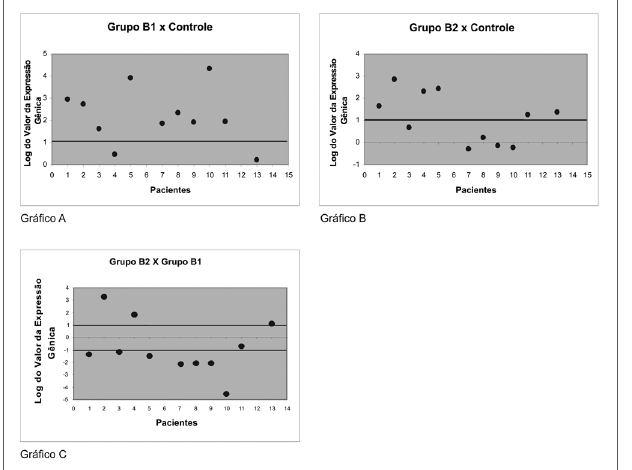
Figura 2. Valor da expressão gênica em log 2 da proteína anti- inflamatória Galectina -1 em pólipos nasais. RT-QPCR foi usado para medir os níveis de RNAm do gene codificador dessa proteína